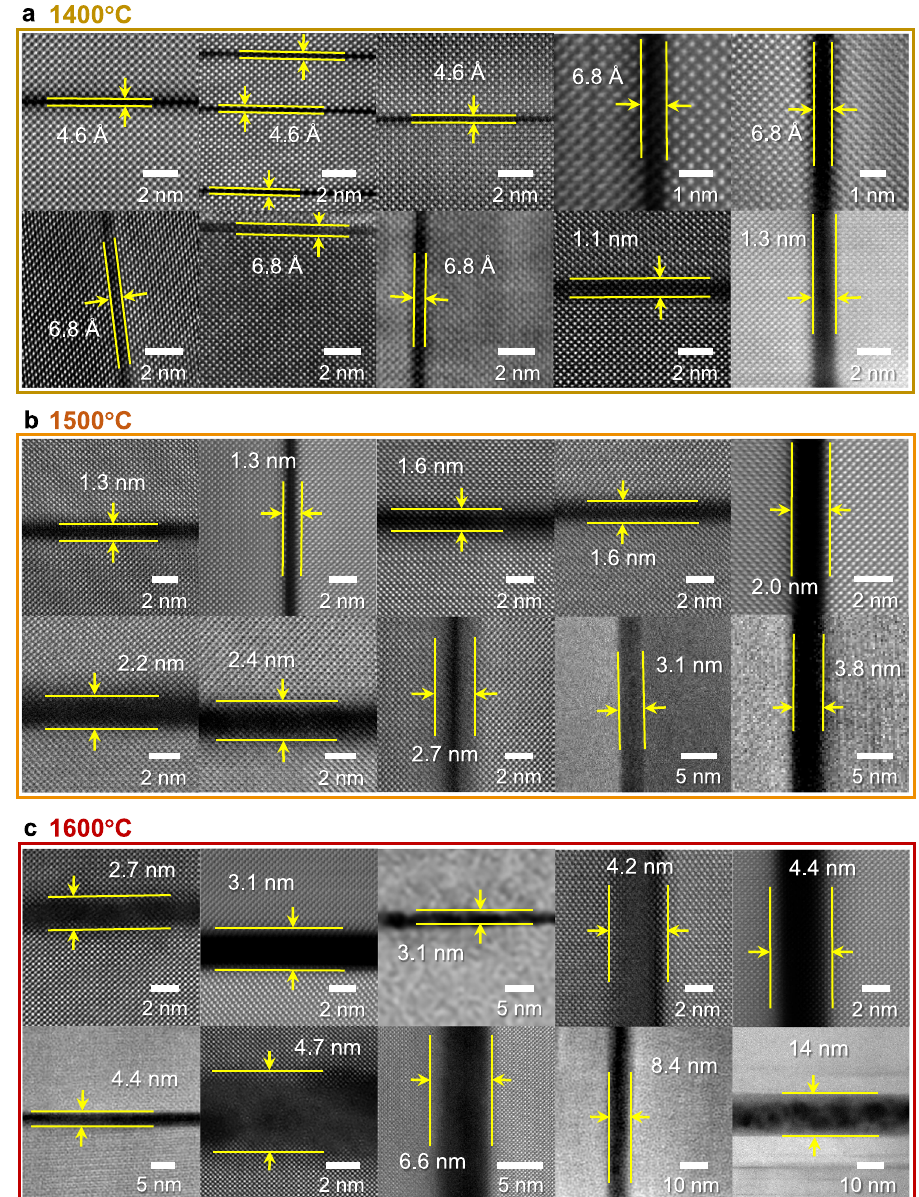
Fig.4|ThreesetsofHAADFimagesforthepremeltedfaultregionsatdifferent temperatures. a − c More than 10 grains in the [100] projection were observed in each case of post-annealing at 1400 ( a ), 1500 ( b ), and 1600°C ( c ). It is noted